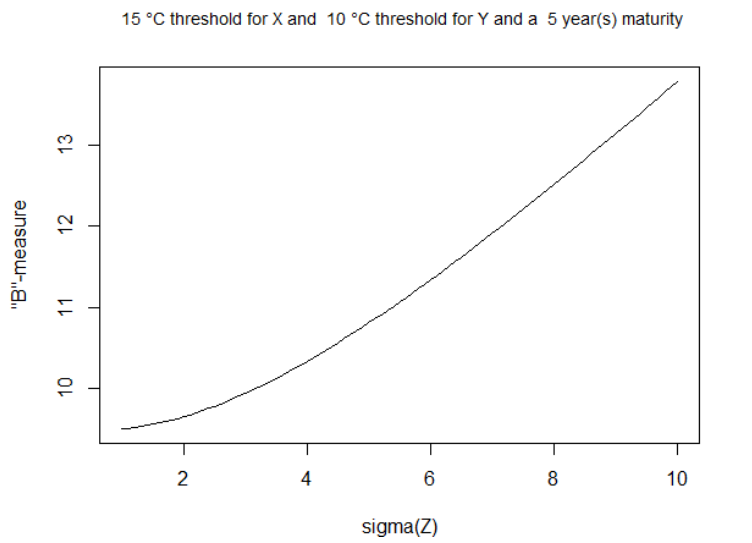
Figure 8. B-measure for the model described in Subsection 3.1 with initial temperature equal to 15 ◦ C for the minimal temperature, 22 ◦ C for the maximum temperature and threshold equal to 10 ◦ C for the minimum temperature and 15 ◦ C for the maximum temperature. The time of maturity is equal to five years. B-measure is plotted as a function of σ to 10